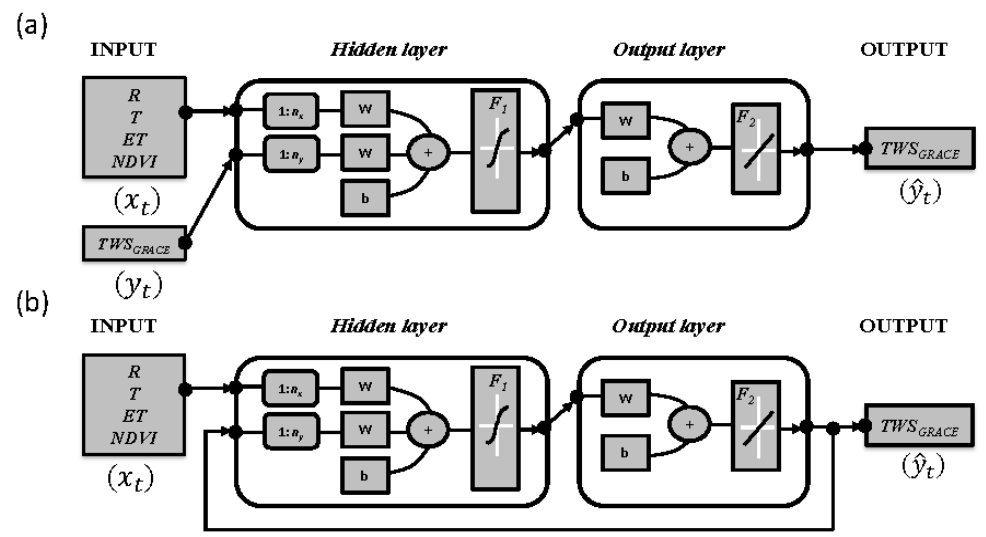
Figure 3. Nonlinear autoregressive with exogenous input (NARX) model architectures adapted and modified from Mark et al. [109]. ( a ) Series-parallel architecture (open-loop) that was used in the training phase, and ( b ) parallel architecture (closed-loop) that was used in the prediction phase. “ W ” and “ b ” denote connection weights and bias, respectively; “ F 1 ” and “ F 2 ” represents the hyperbolic tangent and the linear activation functions, respectively.